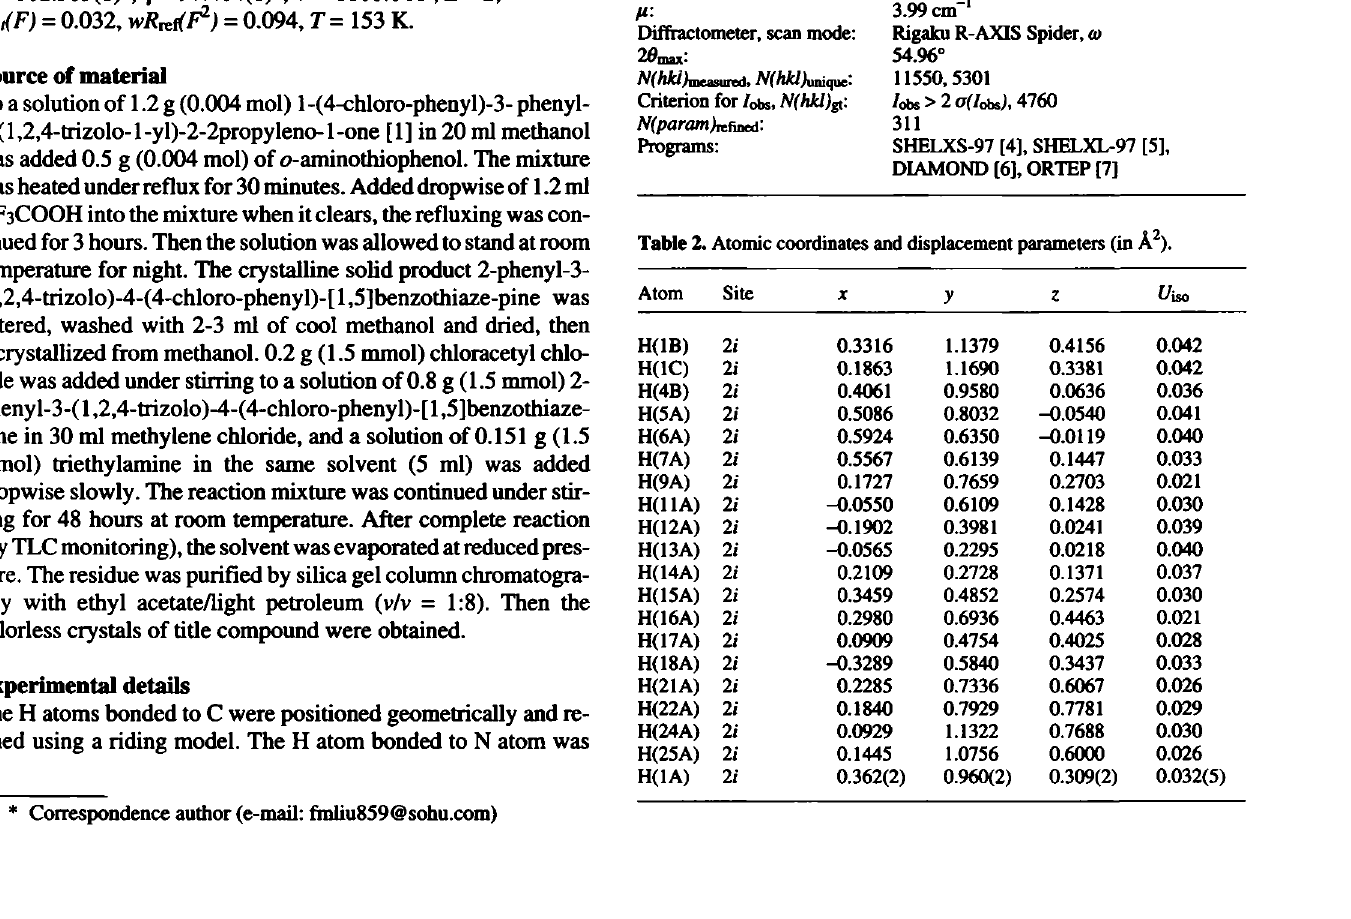
Table 1. Data collection and handling.